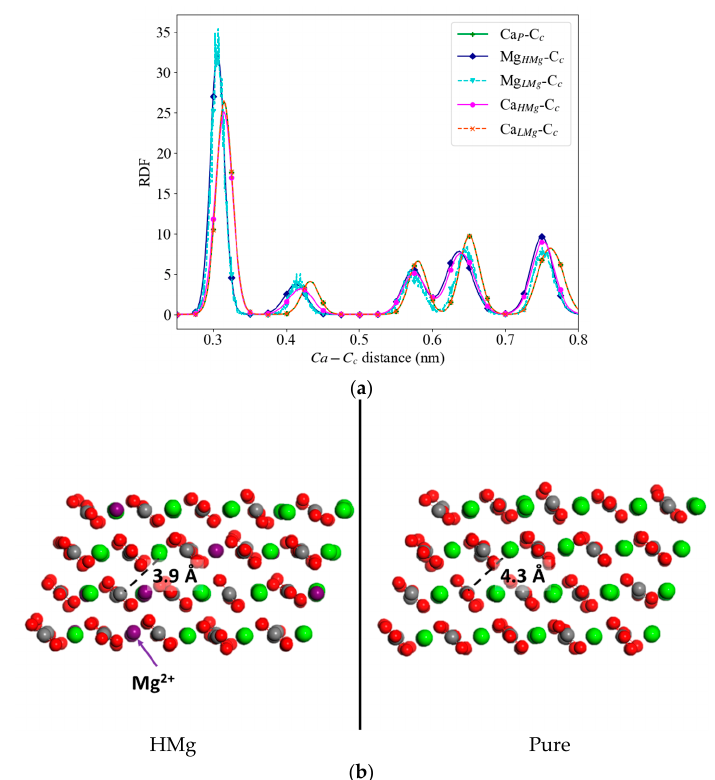
Figure 3. ( a ) Radial distribution function for the cation with the carbon of carbonate in pure, low Mg 2+ concentration (LMg) and high Mg 2+ concentration (HMg) calcite crystals. ( b ) Side view snapshots of the calcite crystal showing the deformation along the c -axis in the HMg (left) compared to pure calcite (right—for average distances see Table S5 and Figure 3a); calcium ions are in green, magnesium ions in purple, carbonate oxygen and carbon in red and grey,